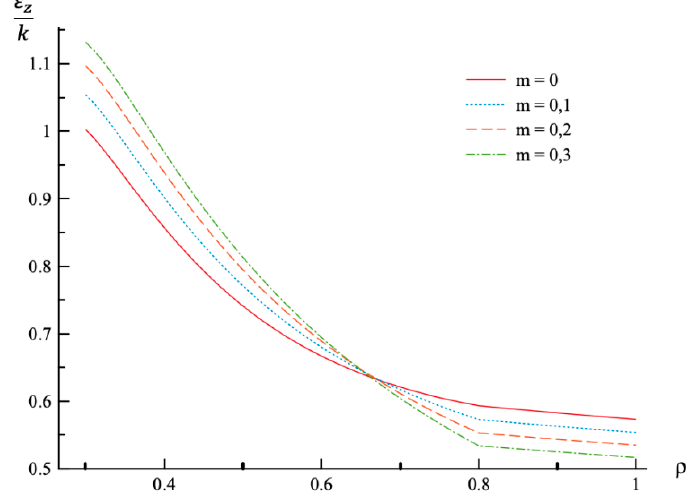
Figure 5. Variation of the axial strain, ε z , with the dimensionless radius, ρ , at p = p f .